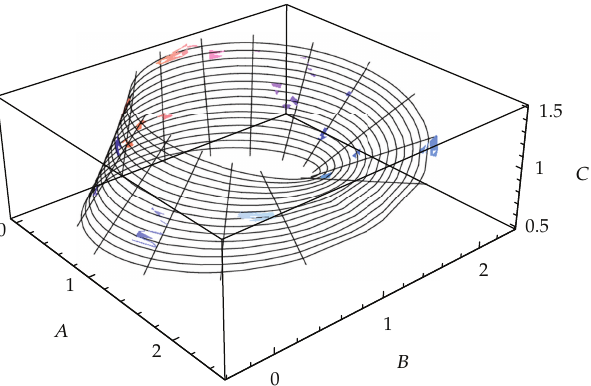
Figure 29: The plot of the M¨obius strip universe for (cid:2) 5.16 (cid:3) with (cid:2) 3.4 (cid:3) and τ (cid:6) 0 → 2 π and Λ (cid:6) (cid:4) − 1 . 1 (cid:5)